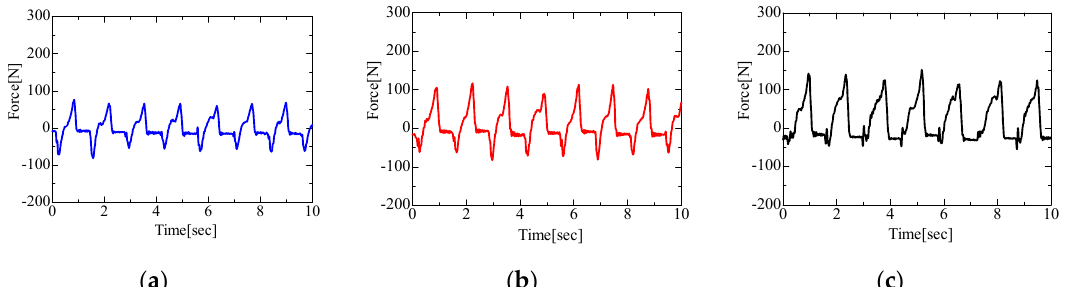
Figure 8. Results for propulsion force in gait conditions: ( a ) low target load; ( b ) medium target load; ( c ) high target load.